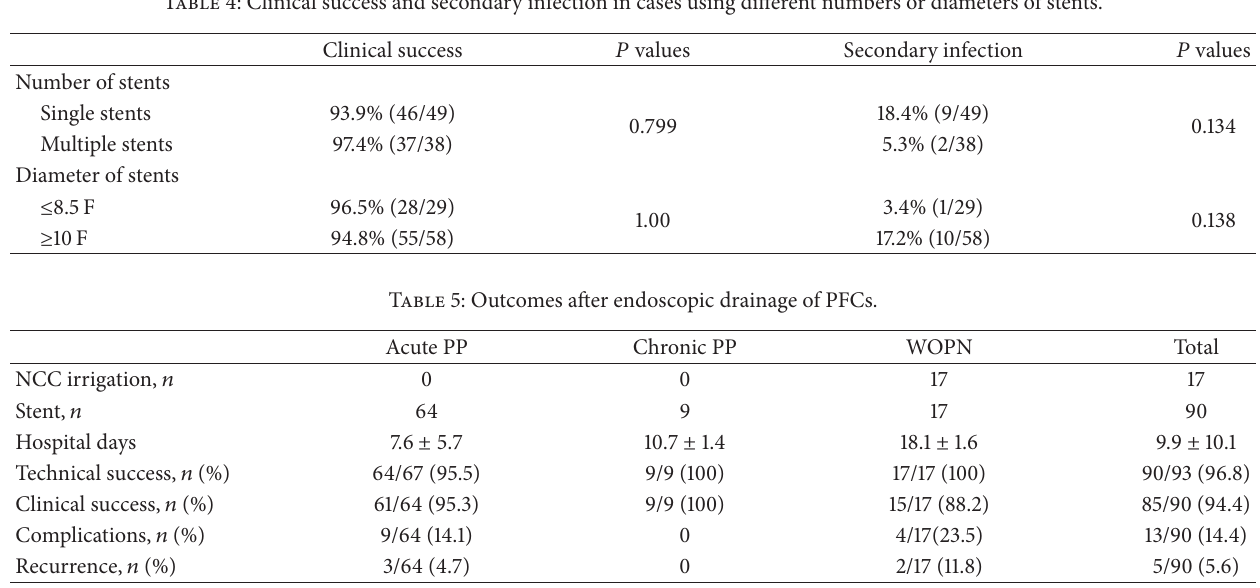
Table 4: Clinical success and secondary infection in cases using different numbers or diameters of stents.